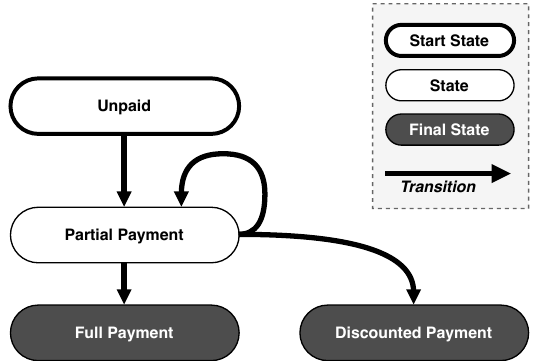
Figure 9. State machine billing